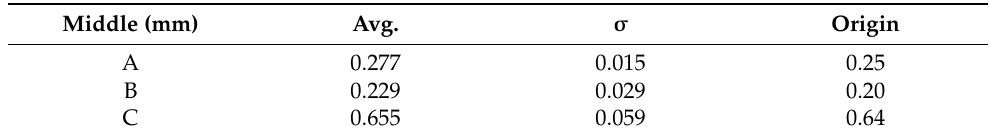
Table 5. Beam dimensions measured by the scanning electron microscope (SEM) from specimens 1 to